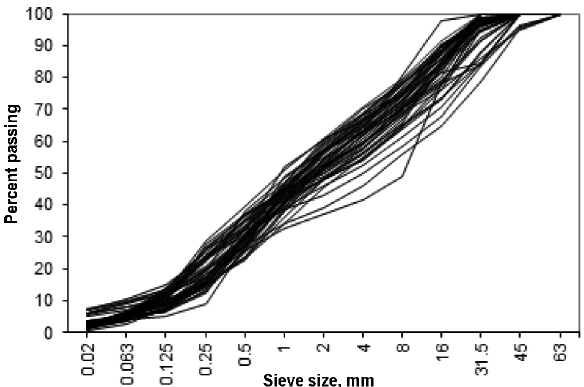
Fig. 5. Gradation of individual samples of railway sub-ballast layer Table 2. Number of ASB samples taken from different locations of the technological process Sample size for the indicator Sampling location